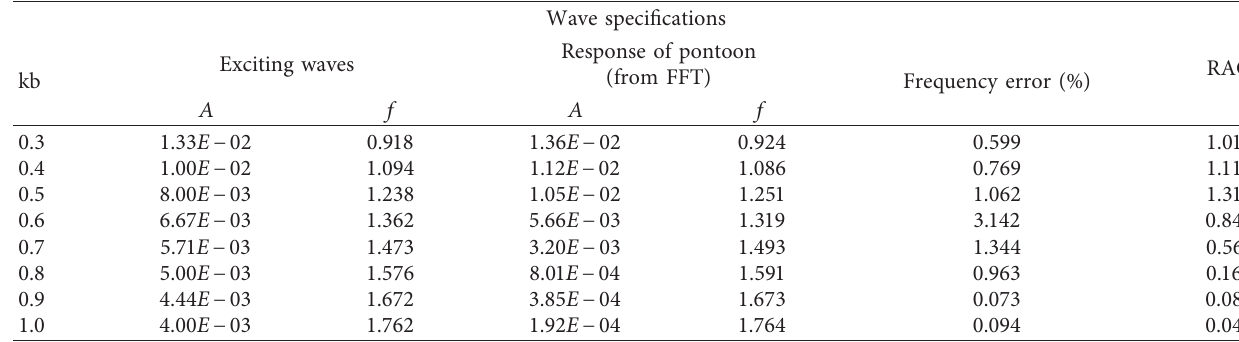
Table 12: Amplitude and frequency of the heaving pontoon for breakwater number